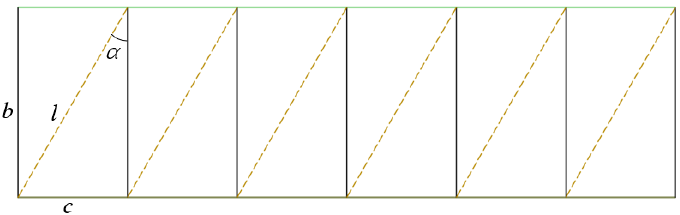
Figure 6. Radial closable Kresling pattern in a planar form. ( n =